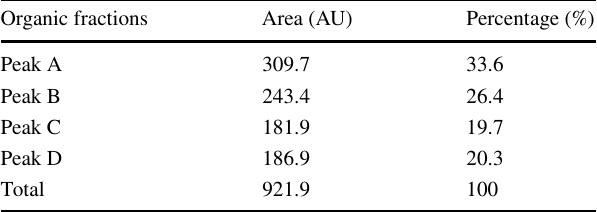
Table 2 The peak area and percentage distribution of the resolved peaks of the HPSEC-OCD chromatograms of source water with peak- fitting